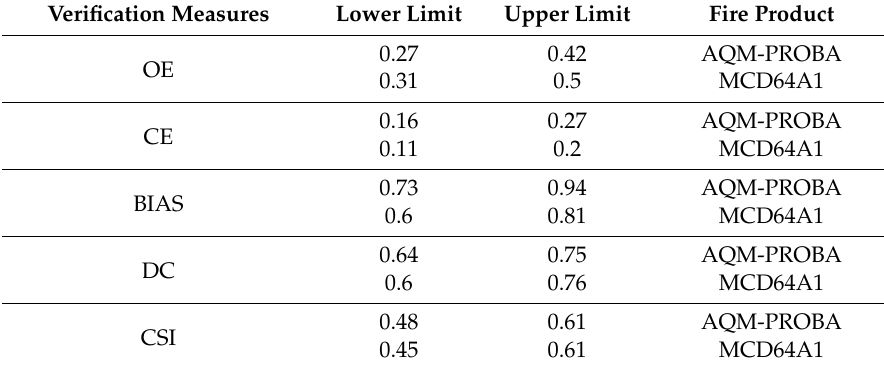
Table 5. Confidence intervals calculated with the Z-test with 95% confidence, for each verification measures (Omission Error (OE); Comission Error (CE); Bias (BIAS); Dice Coefficient (DICE) and Critical Success Index (CSI)) from contingency table and for each burned area product ( Á rea Queimada —Project for On-Board Autonomy-Vegetation burned area product (AQM-PROBA) and Moderate Resolution Imaging Spectroradiometer direct broadcast (DB) burned area product (MCD64A1)). Lower